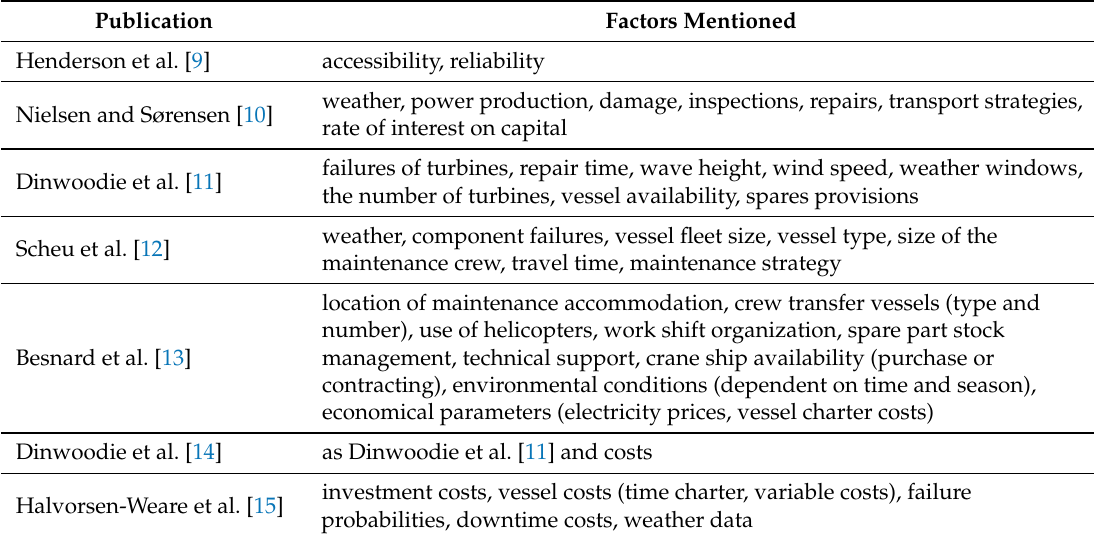
Table 1. This is a table summarizing the factors influential to the offshore wind farm operation and maintenance